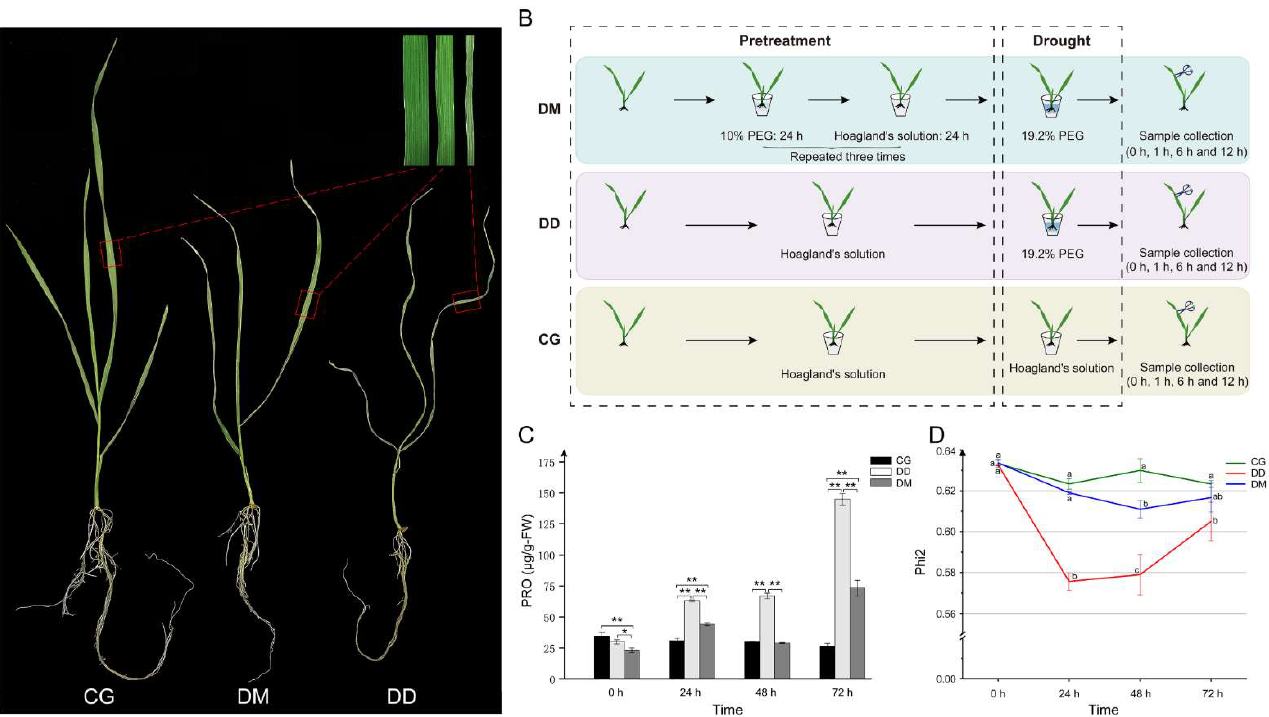
Figure 1. Experimental design and physiological index measurement. ( A ) Drought resistance detec- tion of seedlings in three groups. Trileaf stage wheat seedlings in DD and DM groups were treated with half-strength Hoagland’s liquid medium containing 19.2% PEG for six days, and seedlings grown in normal conditions were used as control. ( B ) Trileaf stage seedlings were divided into three groups, including the control (CG), direct drought (DD), and drought memory (DM). The DM group was pre-treated with 10% (M/V) PEG. Seedlings of the DD and DM groups were then treated with 19.2% PEG, while CG was grown under normal conditions. Whole seedlings of three groups were collected at 0, 1, 6, and 12 h with three biological repetitions and immediately frozen in liquid nitro- gen. ( C ) Proline content comparison amongst the three groups after treatment (19.2% (M/V) PEG) for 0, 24, 48, and 72 h. * p < 0.05; ** p < 0.01. ( D ) Comparison of the efficiency of photosystem II (Phi2) amongst the three groups after treatment (19.2% (M/V) PEG) for 0, 24, 48, and 72 h. Error bars rep- resent the SD. Points on the polyline followed by different letters are statistically different according to the analysis of variance followed by Duncan’s Multiple Range Test (Comparison of different treatments at the same time).